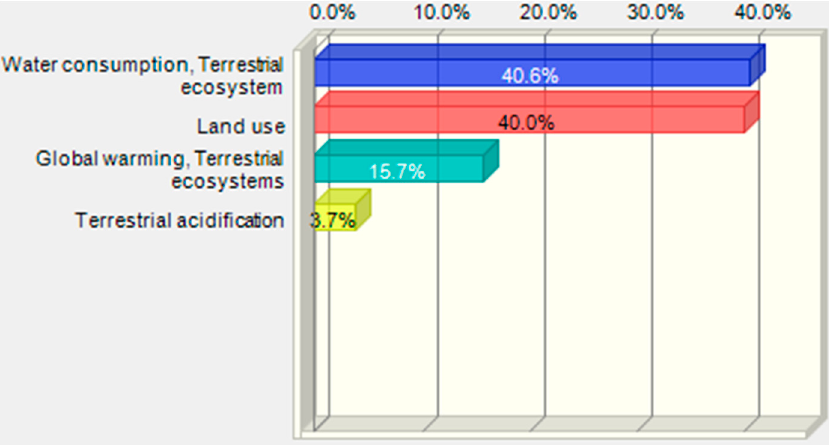
Figure 19. Shares of impact categories in the variance of the total impact of the bottle moulding process in the ecosystem quality area.